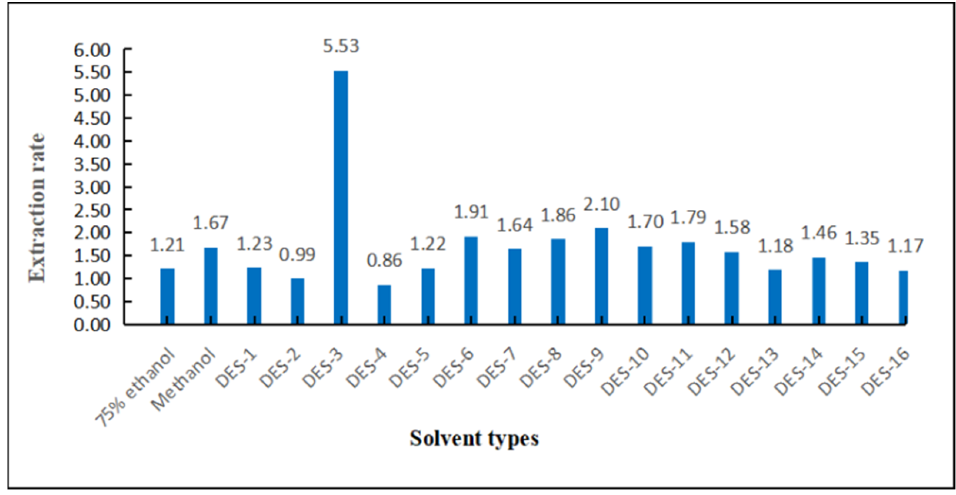
Figure 7. The yield of total coumarins extracted with different organic solvents and DES. Note: The yield of total coumarins was the sum of 7 kinds of coumarins.